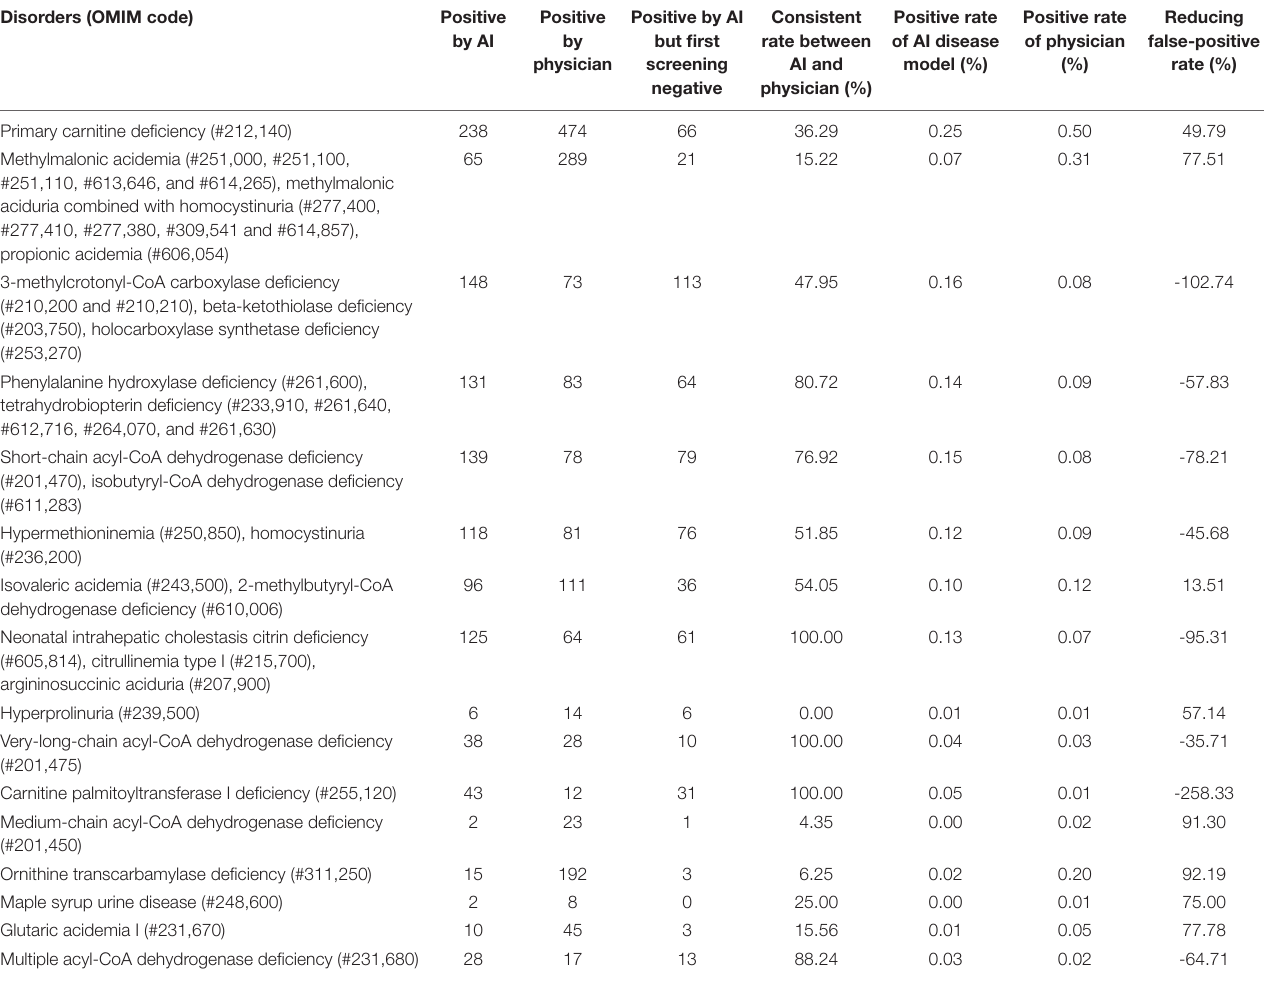
TABLE 5 | Comparison of interpretation results by AI and physician. Disorders (OMIM